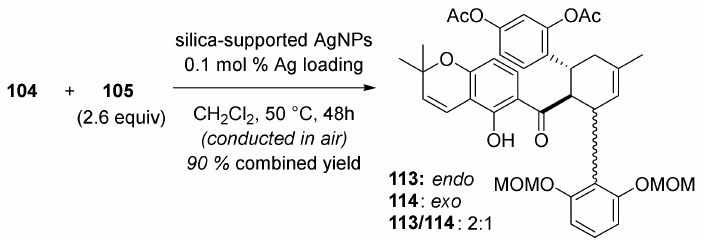
Figure 33. Diels–Alder cycloaddition between 104 and 105 catalysed by